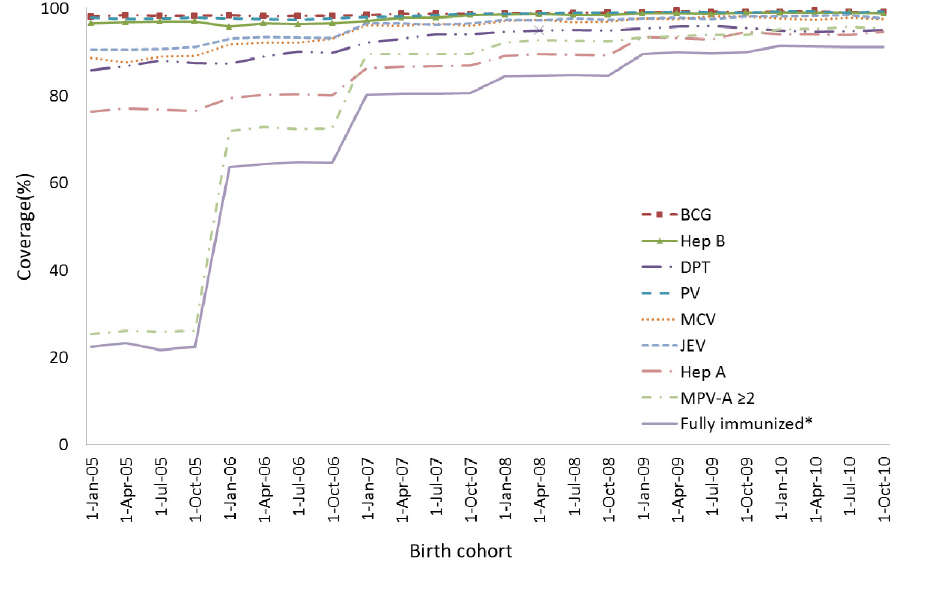
Figure 1. Trends in vaccination coverage estimates for individual vaccines at 12 months of age ( ≥ 3 dose of Hep B, PV and DPT, ≥ 1 dose of BCG, MCV, JEV, “Fully immunized”), by 3-month birth cohorts born between 1 January 2005 to 31 December 2011. Coverage assessment date was 12 months after the last birth date of each cohort.